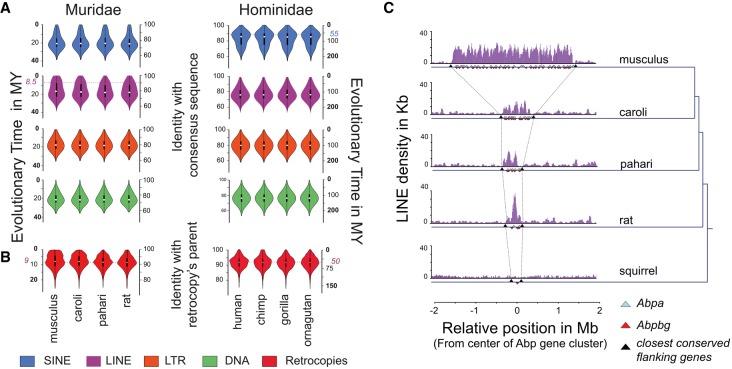
Recent LINE activity can remodel protein-coding gene loci. (A) Violin plots showing the distribution of repeat elements that have the indicated divergence from the ancestral element sequence: (blue) SINE; (purple) LINE; (orange) LTR; (green) DNA. The age of the transposable elements was estimated using the nucleotide divergence from ancestral SINE, LINE, LTR, and DNA elements (Supplemental Methods SM4.1). The dashed lines indicate the estimated peaks of the most recent expansions in Mus musculus and human. (B) Violin plots showing the distribution of retrocopies (red) that have the indicated divergence from their parental genes for each Muridae (left) and Hominidae (right) species. The age of the retrocopies was estimated by the nucleotide divergence from ancestral retrocopies and the corresponding parental genes (Supplemental Methods SM4.3). The dashed line indicates the peak of the most recent expansion in Mus musculus. (C) Representation of the density of LINE elements in the Abp gene cluster for Mus musculus, Mus caroli, Mus pahari, the rat, and the thirteen-lined ground squirrel. The blue and red triangles represent the Abp genes: (blue) Abpa (Scgb1b); (red) Abpbg (Scgb2b). The black triangles represent the closest flanking genes (upstream [Scn1b] and downstream [Gpi1]) shared by the four Muridae species and the squirrel.